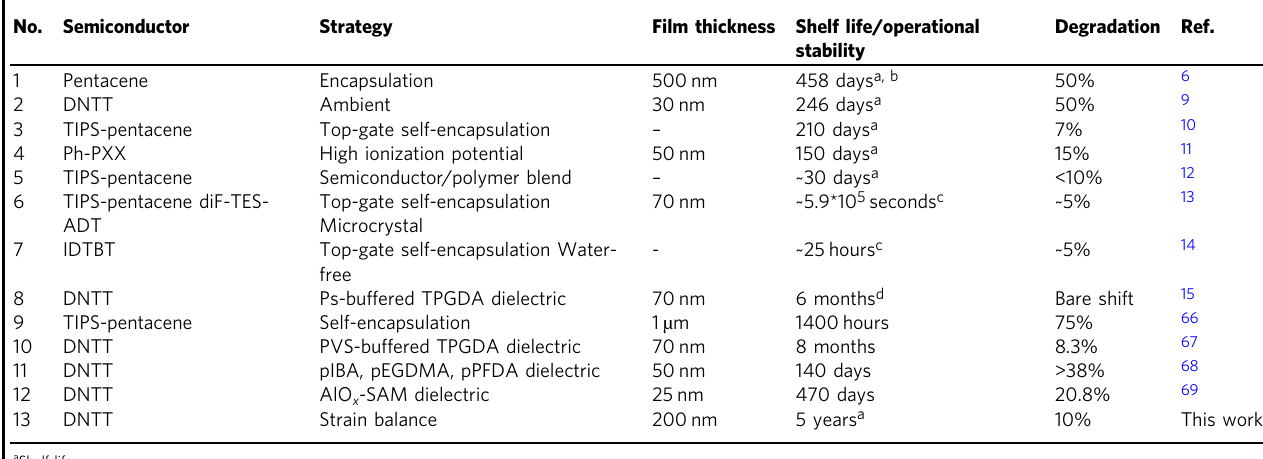
a Shelf life. b Theoretical estimation. c Operational stability. The data are obtained from the literature. d The lifetime was extracted from the same experimental conditions as our